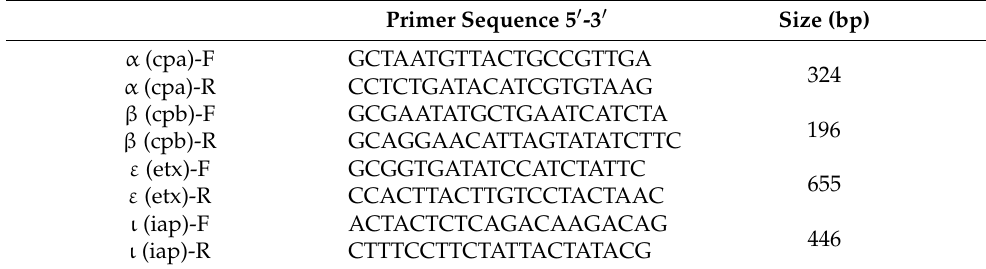
Table 2. Toxin typing primers of C. perfringens